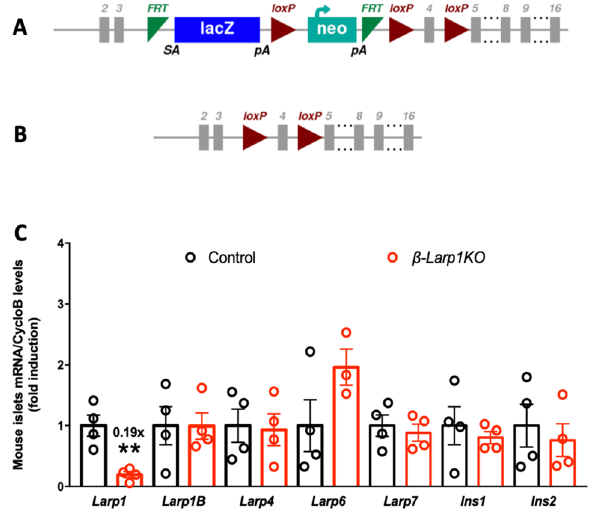
Figure 3. Generation of conditional knockout mice in β-cells (β-Larp1KO). ( A ) Larp1 gene construct used to generate the floxed-Larp1 mouse. Mice containing the targeted Larp1 gene were crossed with a mouse expressing an enhanced variant of Saccharomyces Cerevisiae FLP1 recombinase (FlpE) to remove the lacZ and neomycin-resistance cassettes flanked by the FRT-cutting sites (green), ( B ) Floxed-Larp1 gene after FLP1 recombination and before Cre-recombinase. After crossing with the Rat insulin promoter (RIP)-Cre mouse, exon 4 is specifically disrupted in β-cells. Grey boxes denote Larp1 gene exons. ( A , B ) were modified from the International Mouse Phenotype Consortium (see link in methods) and ( C ) LARP family and insulin mRNA levels in isolated islets from control and β-Larp1KO mice. ** p < 0.01 compared to control mice assessed by Student’s T test. Number on top of Larp1 bar denote fold